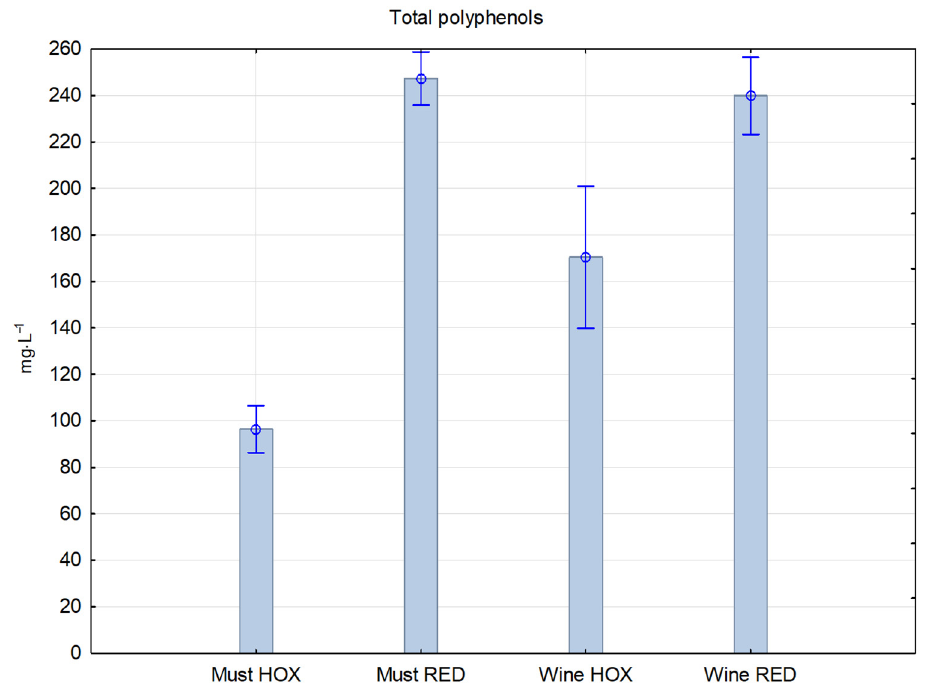
Figure 4. Concentration of total polyphenols in reductive and hyperoxidized musts and wines.